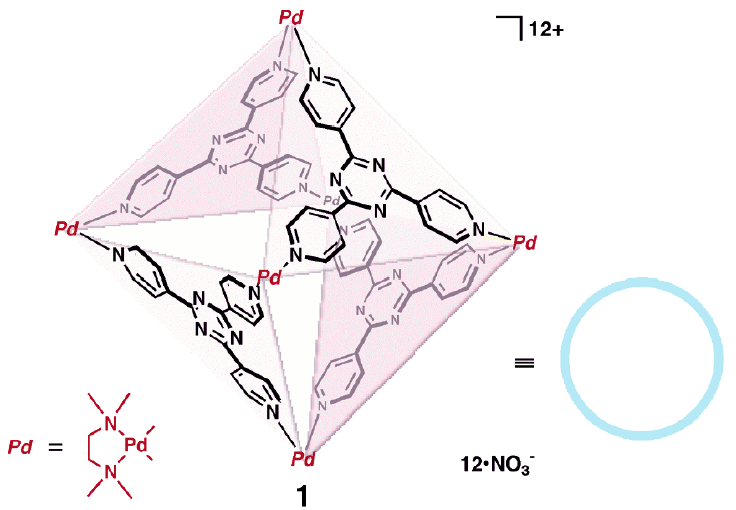
Figure 29. Chemical structure of the Fujita’s Pd6L4 coordination cage. Reprinted with permission from [179]. Copyright (2005) American Chemical Society.